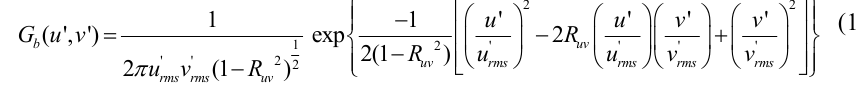
abelled with the subscript